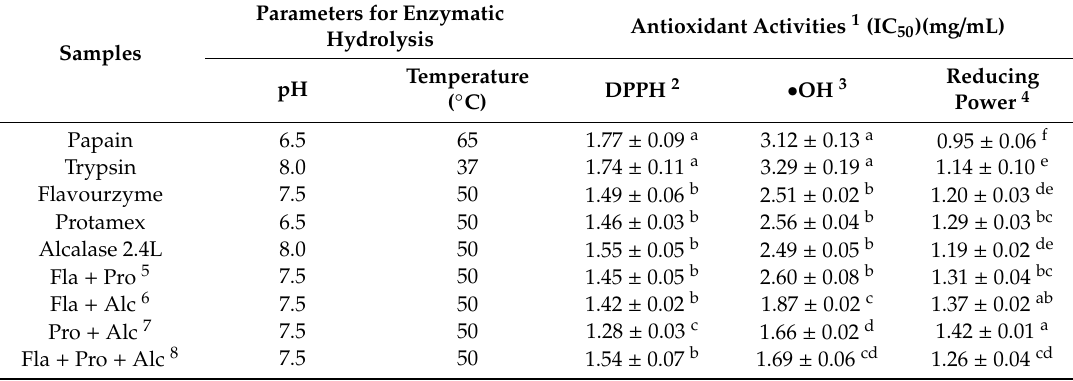
Table 1. Parameters for enzymatic hydrolysis of Schizochytrium limacinum by several single or compound proteases and the antioxidant activities of